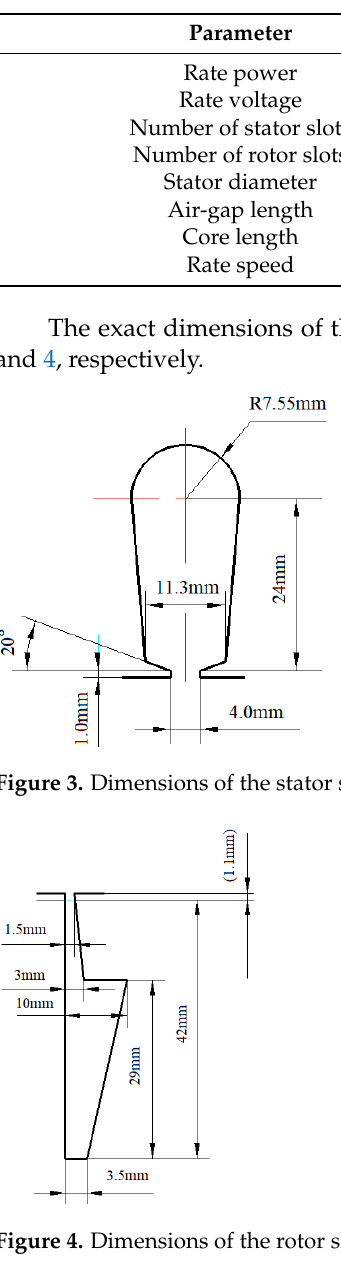
( b ) Figure 5. 2D finite element electromagnetic field simulation models: ( a ) normal operation condition; ( b ) eccentric operation condition. 3.1. Torque and Current Because the air-gap length is 1.1 mm, 30% eccentricity means that the maximum air- gap length is 1.43 mm and the minimum air-gap length is 0.77 mm. When the motor is running under the no-load condition (s ≈ 0), the speed is approx- imated to be 3000 r/min. The torque values under normal operation, under 30% static ec- centricity and under 30% dynamic eccentricity are shown in Figure 6.